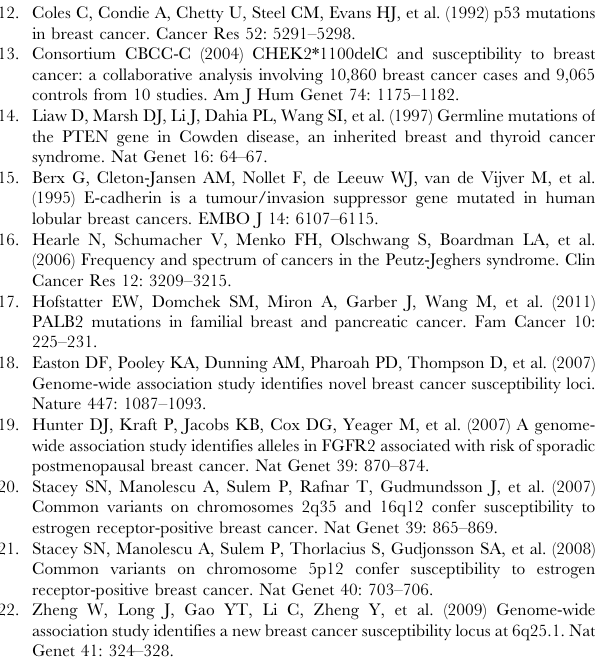
Figure S1 Principal component analysis of (a) Case and control samples of this study with four reference populations from the HapMap database which include Europeans (represented by Caucasian from UTAH, CEU), Africans (represented by Yoruba from Ibadan, YRI) and East Asians (represented by Japanese from Tokyo, JPT, and Han Chinese from Beijing, CHB). (b) Case and control samples of this study. Samples from the major cluster (within the black oval circle) were selected for further analysis. Figure S2 Quantile-quantile (Q-Q) plot for GWAS of breast cancer in Japanese population with (a) All samples ( l = 1.18) and (b) Major Japanese (Hondo) cluster ( l =1.03). Table S1 Association study of the 13 selected loci. (XLS) Table S2 Conditioning analysis of SNPs on chromosome 16q12.1. (XLS)